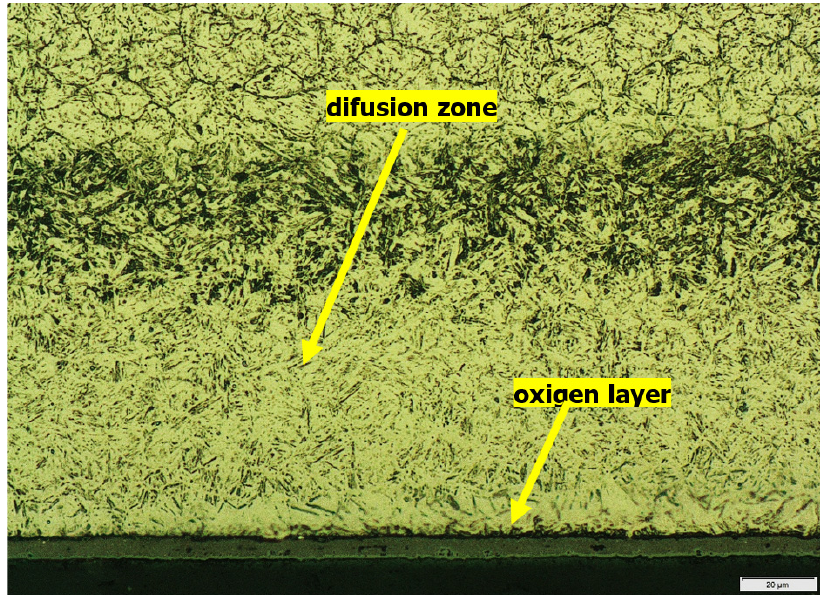
Figure 3. The structure of the v3 sample cross-section, magnification 2500×.